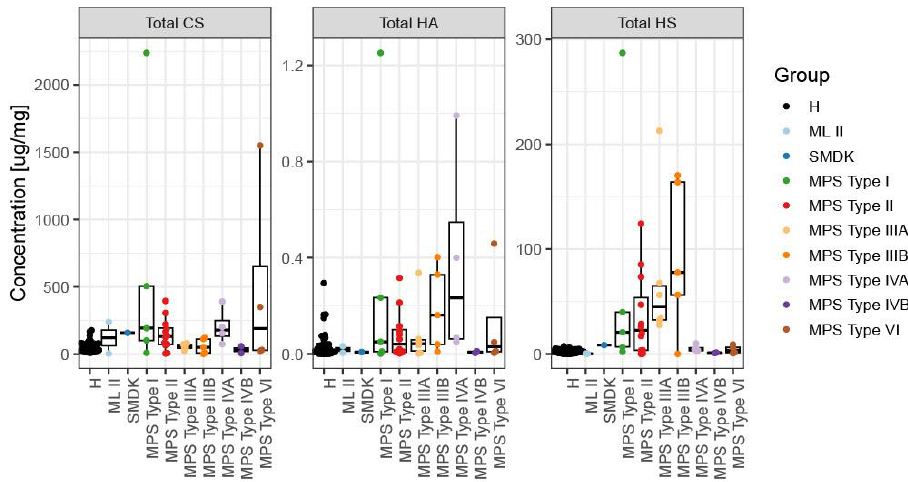
Figure 1. Total CS, HA and HS concentrations ( µ g/mg creatinine) measured in the different groups of MPS patients and controls (non-MPS patients—ML II, SMDK—as well as healthy subjects). SMDK: spondylometaphyseal dysplasia-Kozlowski type. ML II: mucolipidosis type II.